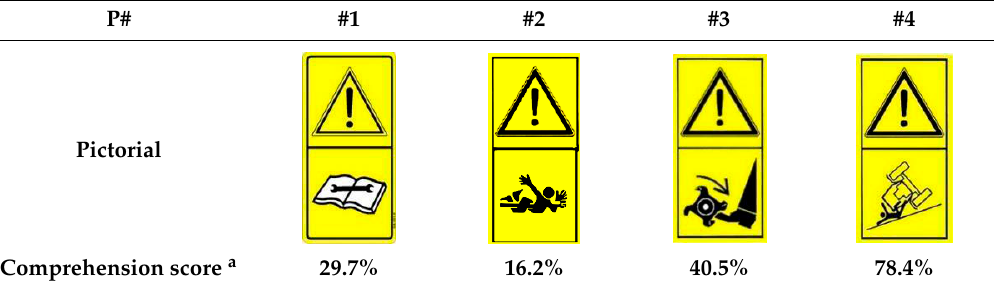
Table 1. Safety pictorials and their meanings (from ISO 11684:1995). Table 3. Comprehension scores for the four safety pictorials studied.